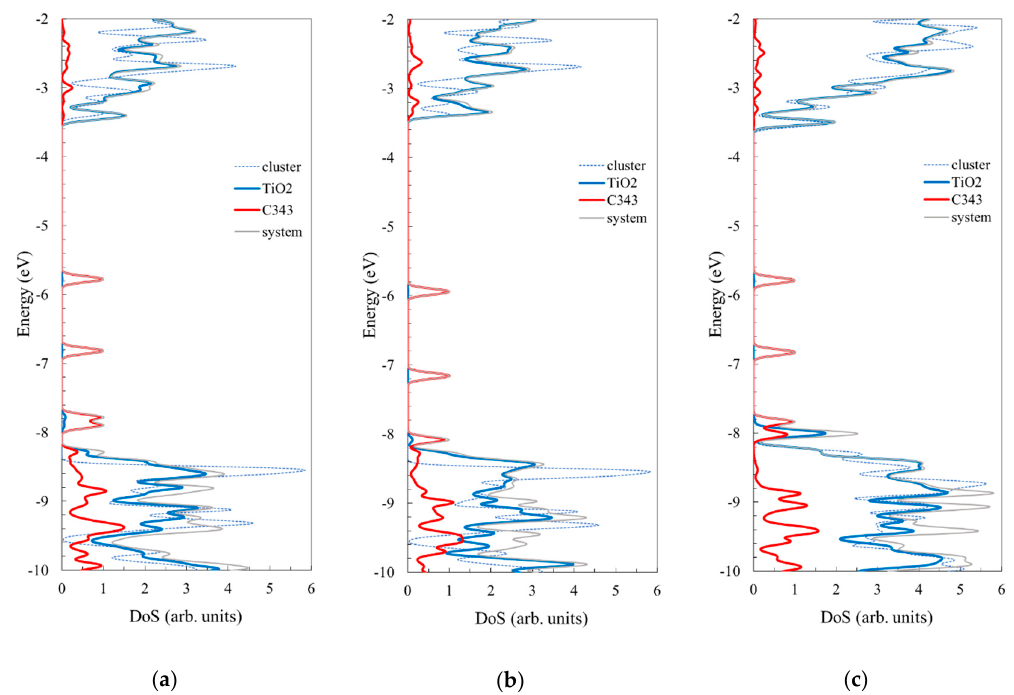
Figure 9. The density of states (DoS) of the systems consisting of the C343 molecule adsorbed on the Ti 14 O 30 H 4 cluster via ( a ) two or ( b ) three O–Ti bonds and on the Ti 24 O 50 H 4 cluster ( c ). Dotted curves represent the density of states of the corresponding bare Ti n O 2 n +2 H 4 clusters ( n = 14, 24). Calculations were performed by DFT at the B3LYP/LANL2DZ level in water solvent. Energy levels were convoluted with Gaussian distributions with of 0.1 eV full width at half maximum.